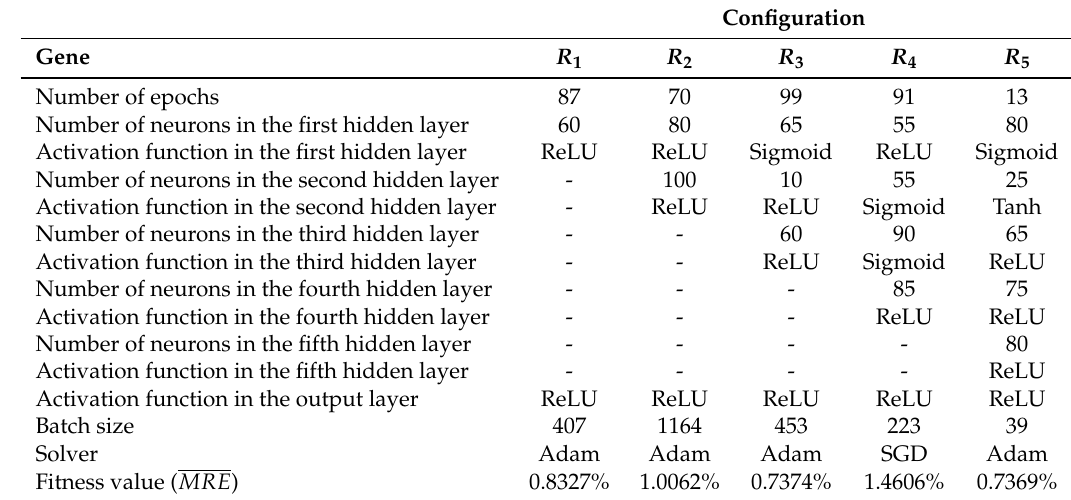
Table 7. MLP configurations as a result of the GA implementation with MRE as a fitness